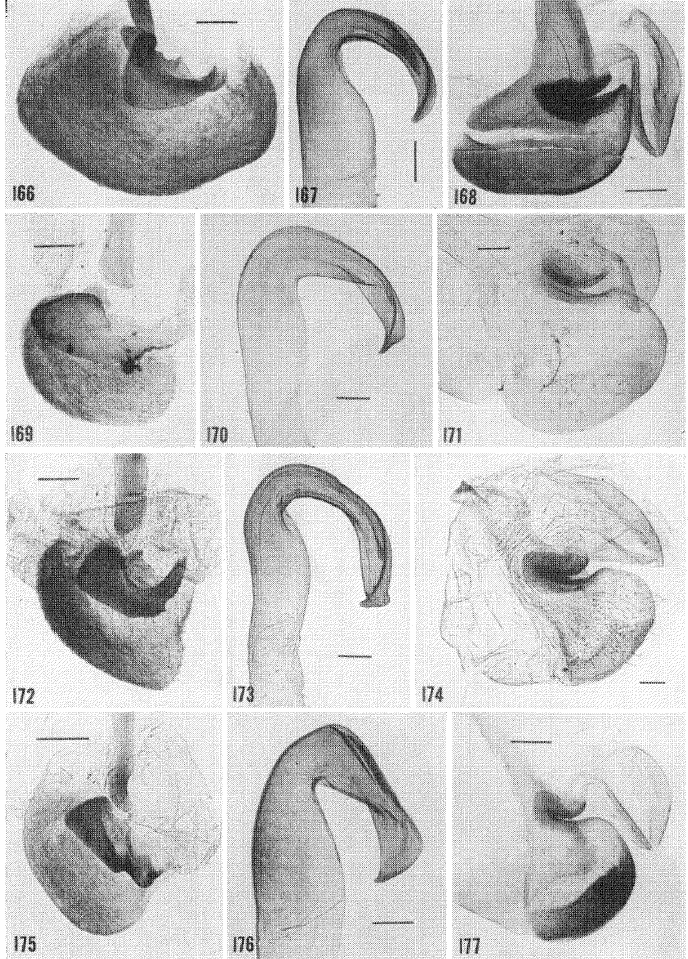
Figs. 166-177. Cockroach male genitalia. 166-168. (175 USNM). Epi- lamlSra hamiltoni. Pico, Turquino, Cuba (det. Gurney). 169-171. Epilampra bromel adarum. Panama. (det. Huber). 172-174. (184 USNM). E15ilamIra Tatunae. Pozo Jkzul, San Jos6, Costa Rica (det. Gurney). 175-177. Epilamlra fugax. Paratype of Audreia fugax Bonfils. Saint Franeoise Anse-a l’Eau, Guadeloupe. (scale 0.2